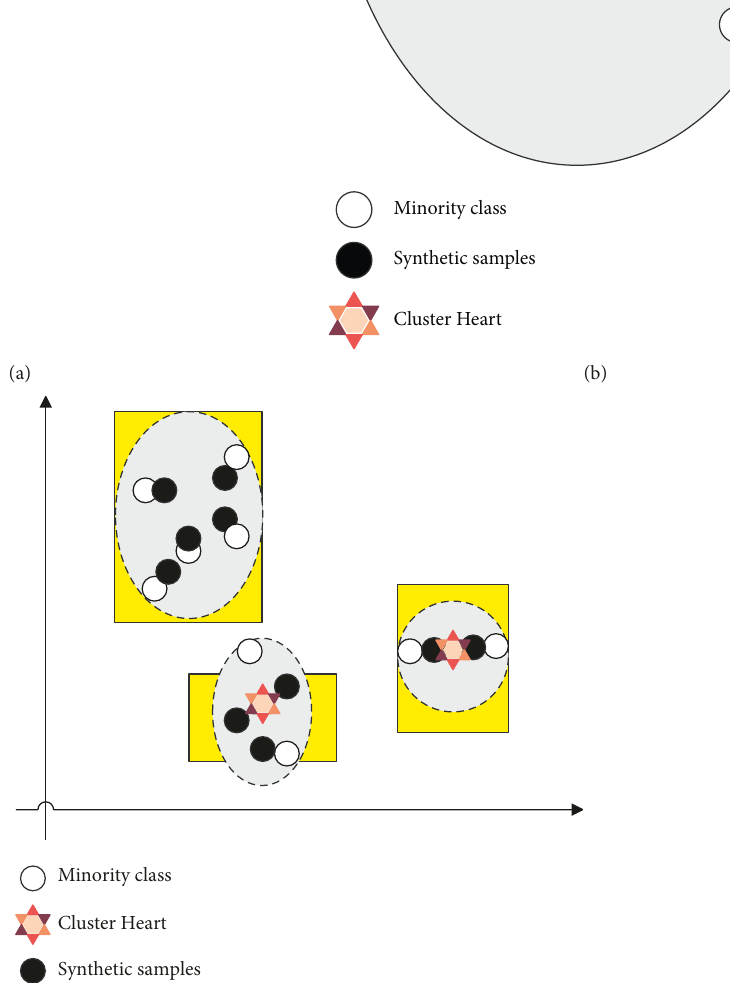
. (c) Synthetic samples of 2